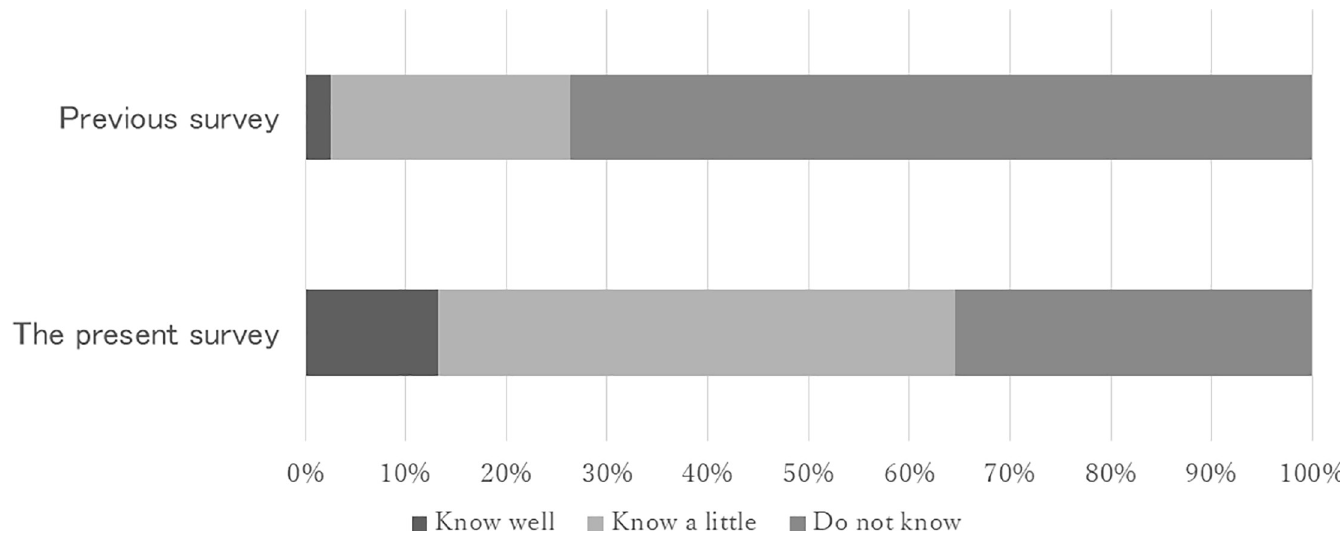
Fig 1. “Do you know the contents of the Mental Health and Welfare Act?” (compared with a previous survey [16]).